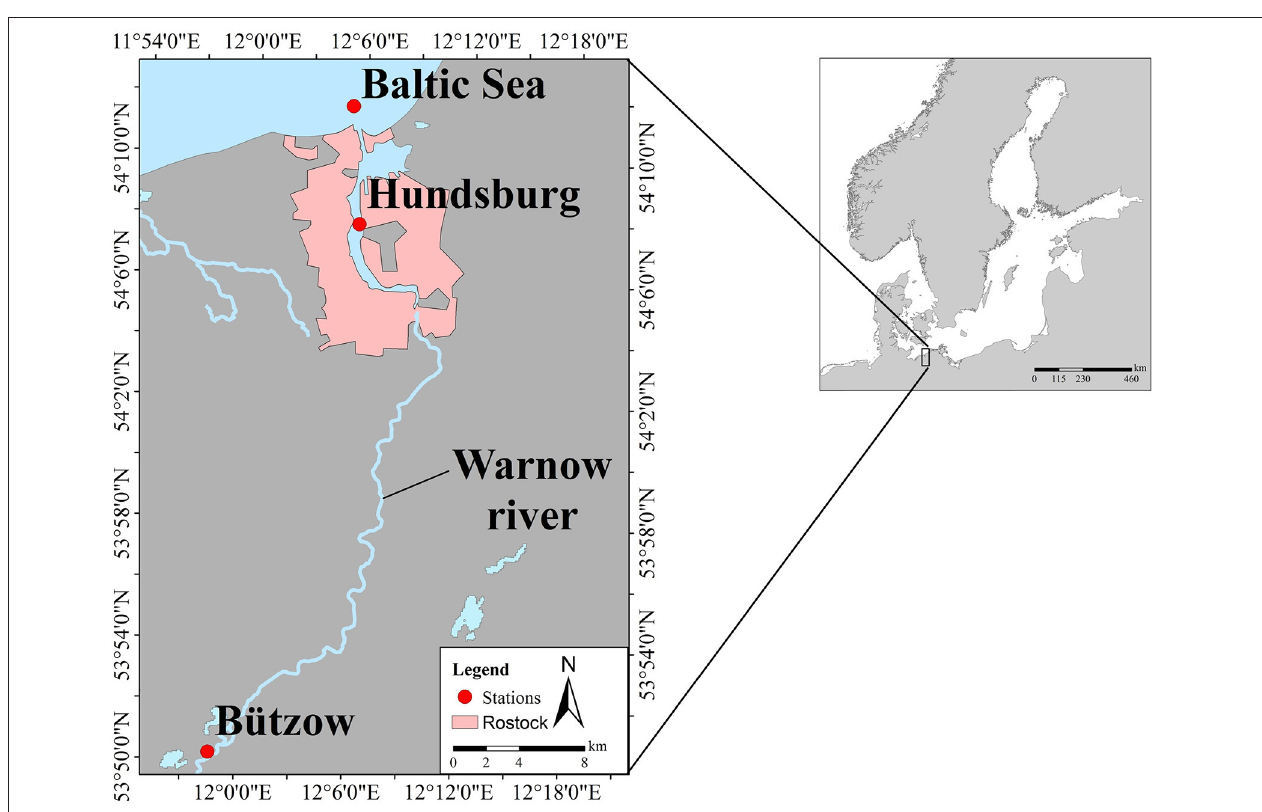
FIGURE 1 | Study area showing the three stations in a lowland catchment area in northern Germany: Bützow (Warnow river), Hundsburg (Warnow estuary, city of Rostock), and Baltic Sea (coastal zone of Baltic Sea).